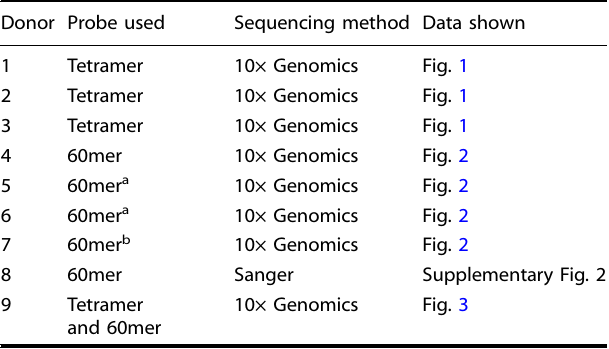
Table 1. Summary of all donors from whom BCR sequences